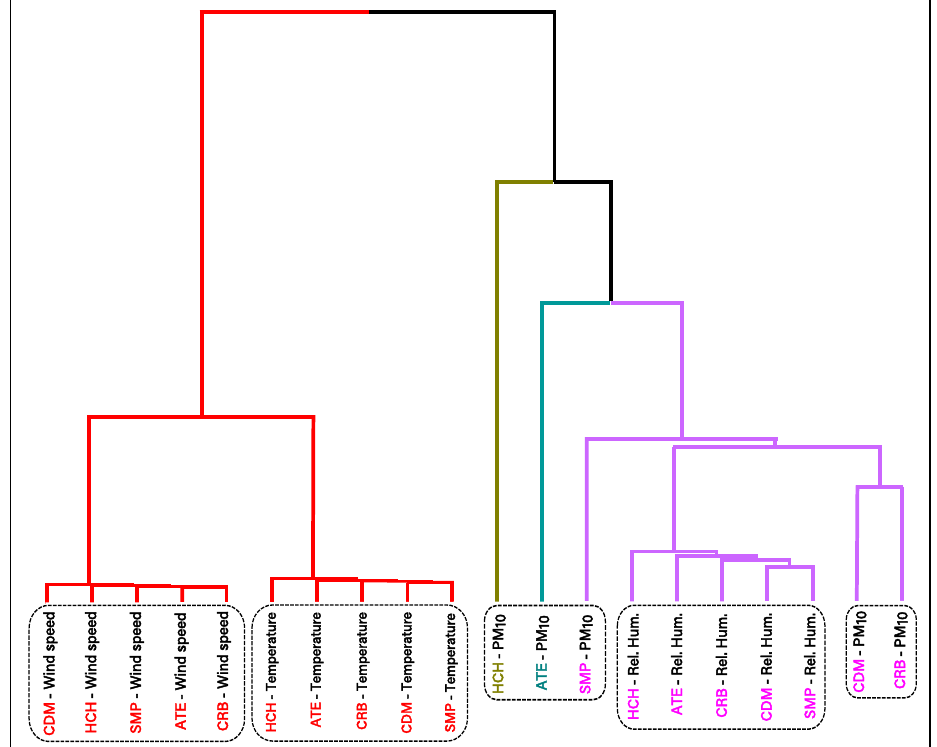
Figure 12. Plot hierarchical clustering dendrogram of meteorological variables and PM 10 of the five monitoring stations as a result of the dynamic correlational analysis between the different time series. The generation of distinguishable clusters such as those made up of the same meteorological variable is